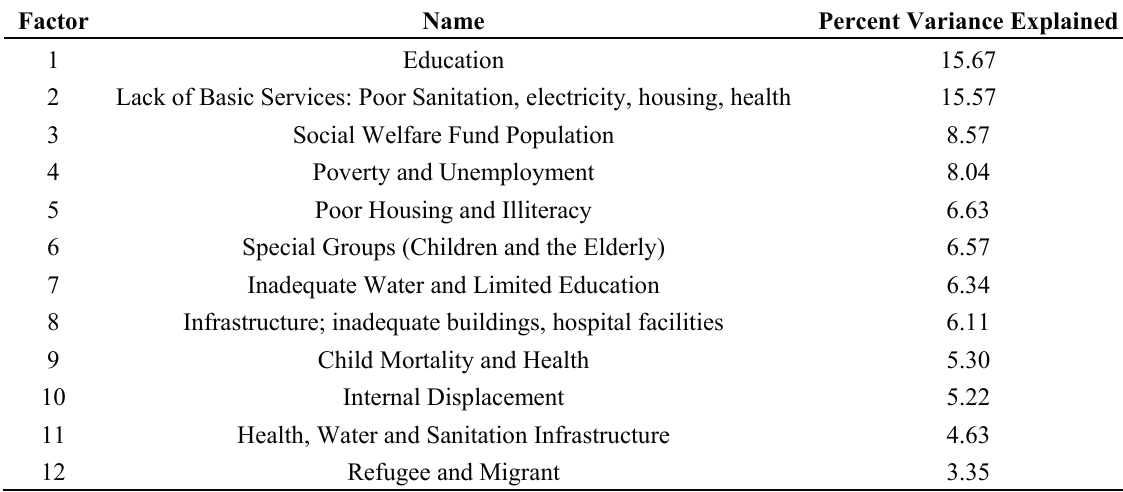
Table 2. The twelve underlying factors used to construct the social vulnerability index of governorates of